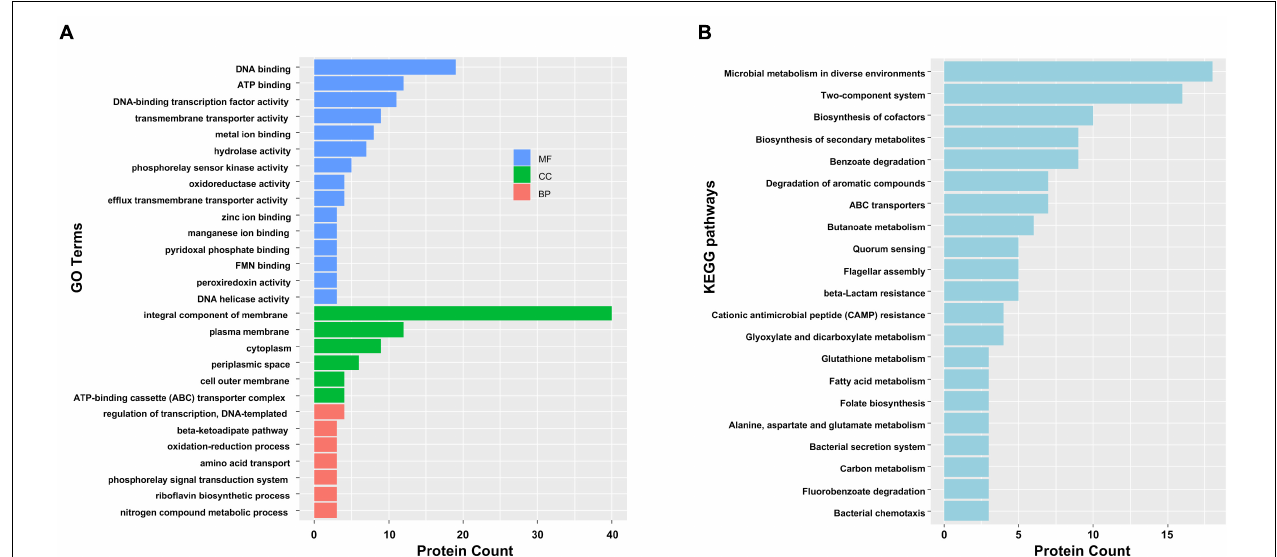
FIGURE 4 | Functional categorization analysis of upregulated DAPs in the presence of IAA. (A) Major enriched GO terms of IAA-up DAPs in molecular function (MF), cellular component (CC), and biological process (BP) terms. The statistics with more than 3 proteins at GO level 2 are shown in this figure. (B) Major enriched KEGG pathways of IAA-up DAPs with at least three